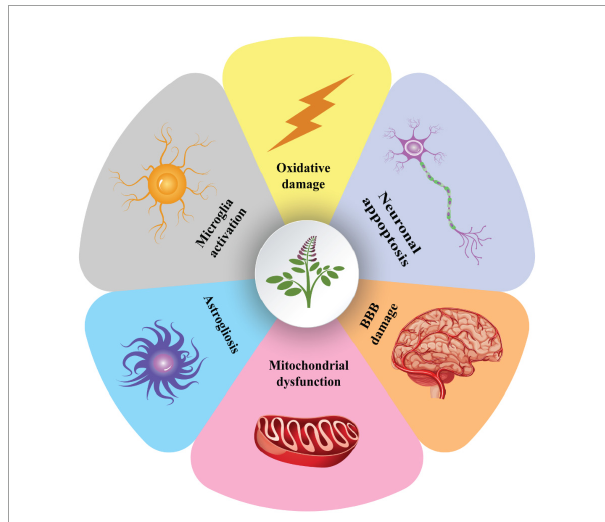
FIGURE5 The cellular processes behind the neuroprotective properties of glycyrrhizin. Glycyrrhizin may enhance the integrity of the blood-brain barrier by preventing astrogliosis, neuronal apoptosis, microglia activation, oxidative-induced cellular damage, and mitochondrial dysfunction. These methods enable glycyrrhizin to boost anti-excitotoxicity (for epilepsy treatment), decreasing axonal damage and brain edema (TBI improvement), cognitive and motor function improving (AD and PD treatment), and reducing demyelination (MS treatment). MS, multiple sclerosis; TBI, traumatic brain injury; PD, Parkinson; AD, Alzheimer’s